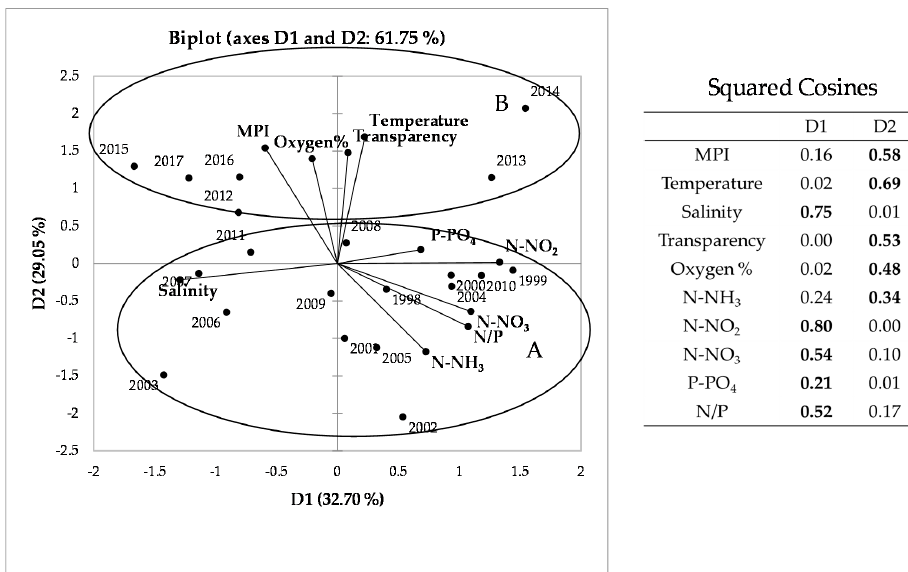
Figure 5. Principal component analysis (PCA. R-mode; Cluster A = years 1998–2011; Cluster B = years 2012–2017) and squared cosines of the variables: values in bold correspond, for each variable, to the factor for which the squared cosine is largest. Table 4. Mann–Whitney test of the hydrochemical parameters [17], MPI, its four metrics and main blooming species, in the periods 1998–2011 and 2012–2017. SD, standard deviation; n , number of observations; p , probability level.